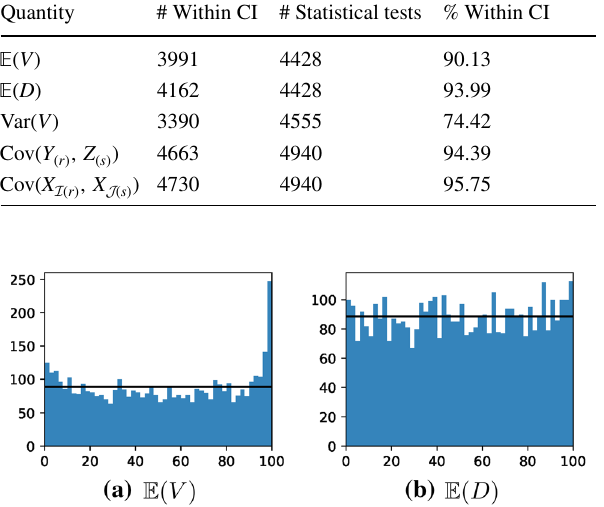
Table 1 The number of statistical tests with the centered 95% confi- dence interval containing the derived theoretical value for each quan- tity of interest. If a theoretical value derived in Sects. 4 or 5 is exact, its associated 95% CI should contain the theoretical value in 95% of the statistical tests Quantity